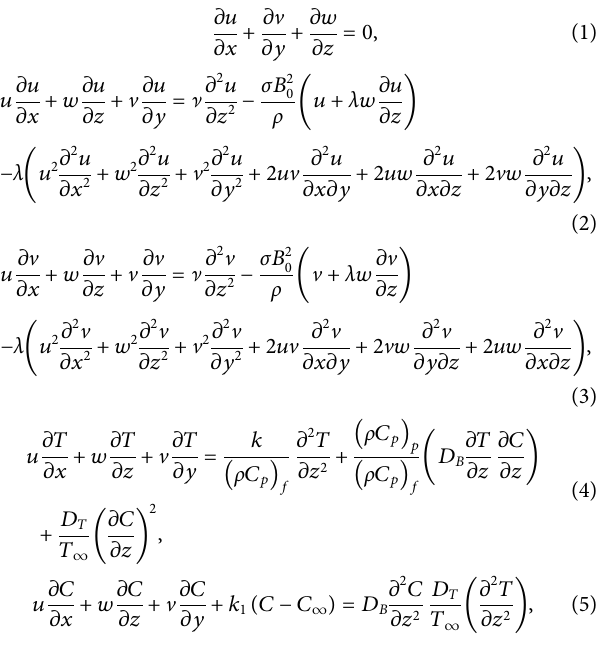
(2022) inspected the MHD micropolar nanoparticle fl ow past an